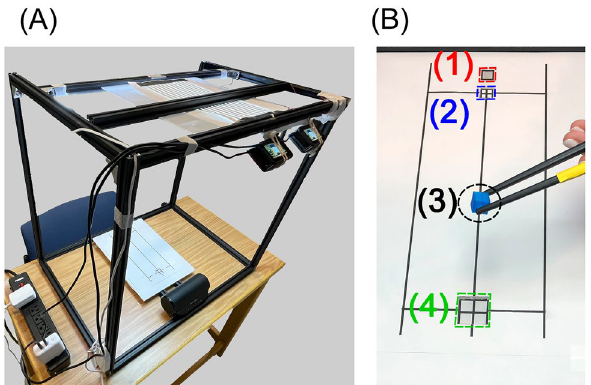
Figure 4. Experiment 3 setup. ( A ) Chopstick object pick-up test workstation. The workstation was constructed using aluminum extrusion profiles. On the back top side of the workstation, two cameras on a dual twin mount were installed. The cameras were positioned at a 30° angle from the table. The test template was positioned in the center of the table. The workstation’s top was illuminated by an LED light. To provide auditory cues, a Bluetooth speaker was placed on the back side of the table. ( B ) The chopstick object pick-up test template. (1) Chopstick holding position. Participants positioned the tips of their chopsticks at this chopstick holding spot at the beginning of each trial. When a participant hears the whistle, they began moving the chopsticks to pick up the object. (2) Target object home location. The target plastic block is placed at this home position at the start of each trial. (3) Target object—blue plastic block. This blue-colored plastic block sized 1 cm on each edge. A 3-D printer was used to create this object. (4) Target location. The participant moves the plastic block from the home location to this location in 5 s for each trial. The target area measured 2 × 2 cm 2 . A trial was regarded successful if the participant correctly placed the plastic block in this area without dropping it within five